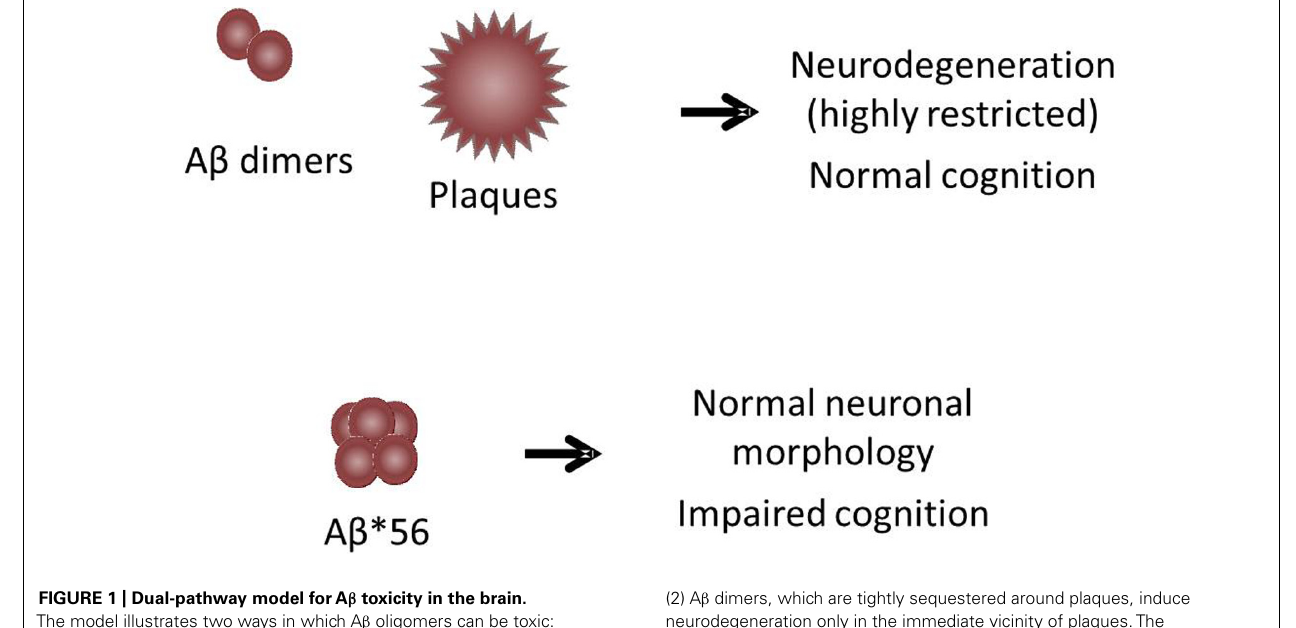
FIGURE 1 | Dual-pathway model forA β toxicity in the brain. The model illustrates two ways in which A β oligomers can be toxic: (1) A β *56, which is diffusely distributed throughout the brain parenchyma, induces widespread synaptic dysfunction, leading to pathological processing of tau and subsequent neurodegeneration over a wide